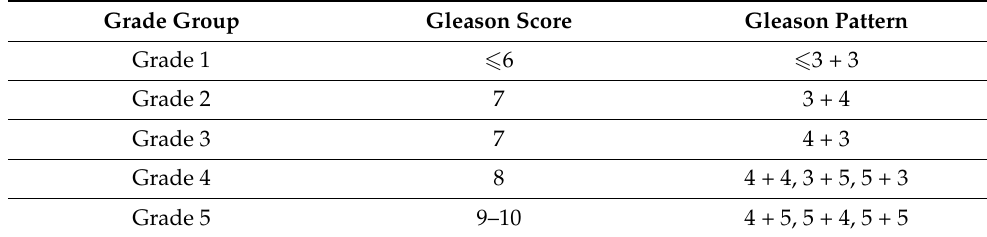
Table 2. New histological grade group classification of prostate cancer